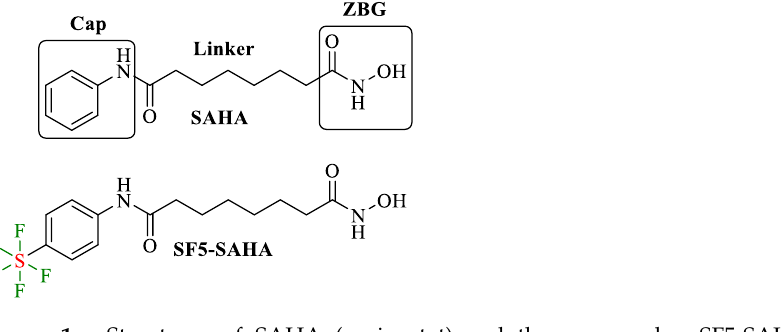
Figure 1. Structures of SAHA (vorinostat) and the new analog SF5-SAHA (ZBG = zinc-binding group).